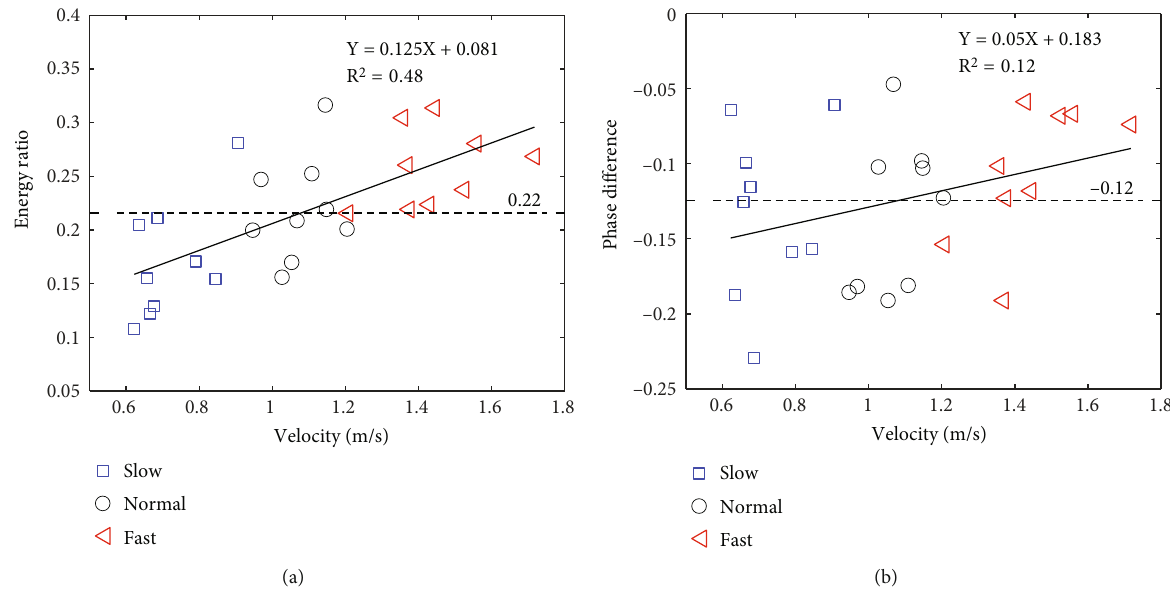
Figure 6: Results of regression analyses between the walking velocity and energy ratio (a) and between the walking velocity and phase di ff erence (b). The dashed line in each fi gure corresponds to the mean value under all the conditions (